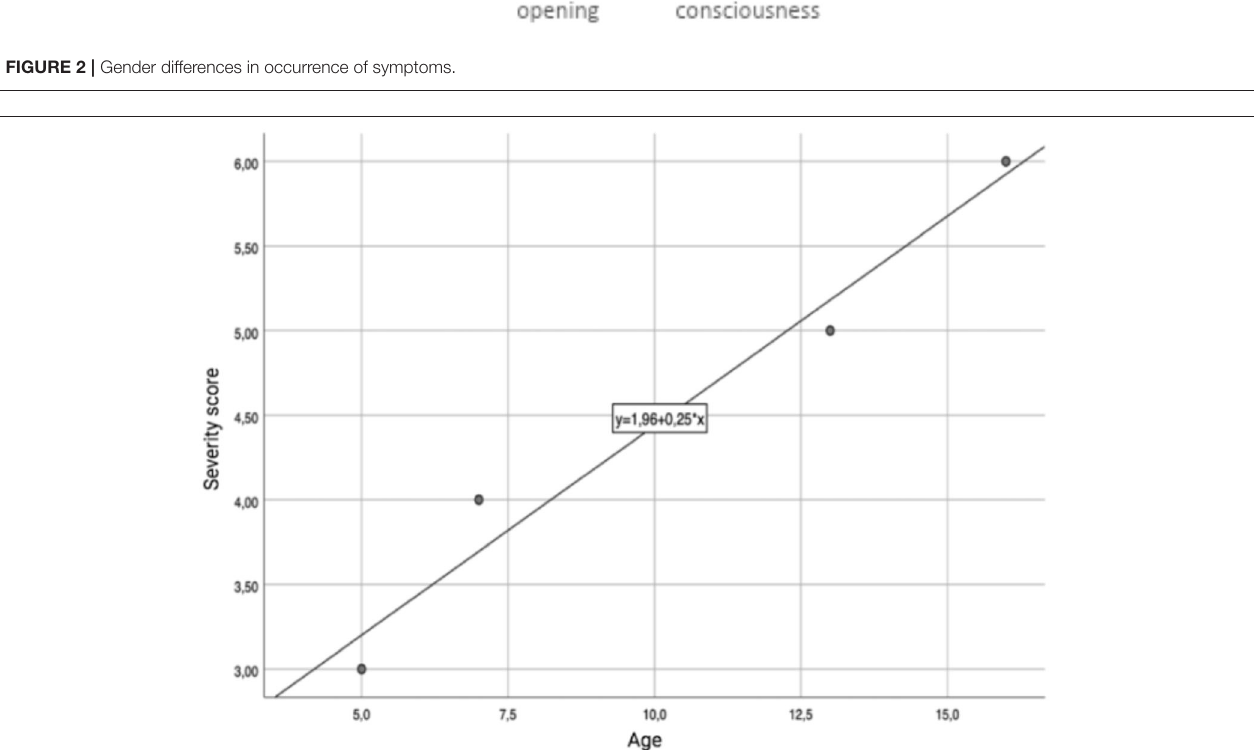
FIGURE 3 | Age-severity linear correlation in